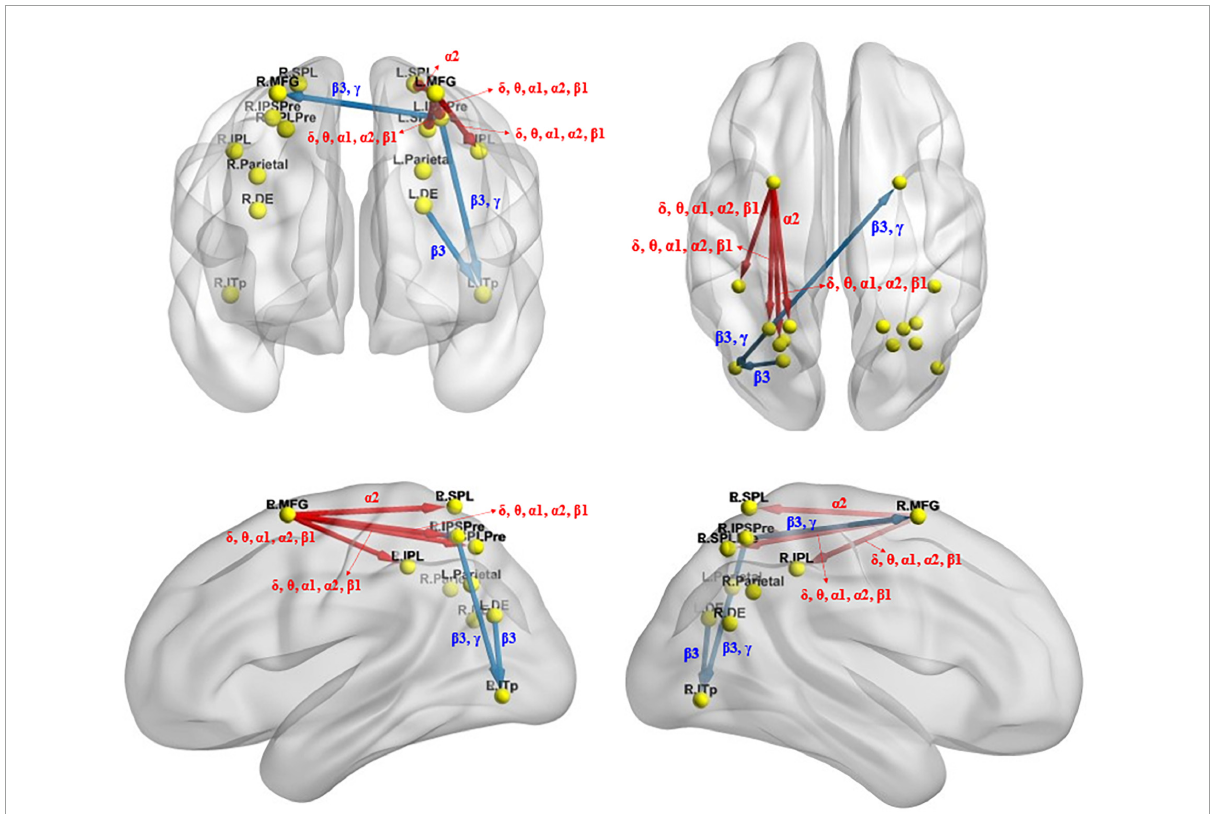
FIGURE6 Changes in effective connectivity under the identical condition after total sleep deprivation. Compared with before sleep deprivation, the effective connectivity from the L.MFG to the L.IPSPre, L.IPL, L.SPLPre, and L.SPL were significantly enhanced. The effective connectivity from the L.DE to the L.ITp, from the L.IPSPre to the L.ITp and the R.MFG were significantly reduced. Blue indicates that the strength of the effective connectivity is smaller after total sleep deprivation than before; Red indicates that the strength of the effective connectivity is greater after total sleep deprivation than before. The arrow indicates the direction of the connectivity; From top to bottom and from left to right: coronal view (frontal side) , axial view (dorsal side) , sagittal view (left side) , sagittal view (right side) . The main statistically significant results are summarized. L.ITp, left posterior inferior temporal lobe; R.ITp, right posterior inferior temporal lobe; L.DE, left dorsal extrastriate visual areas; R.DE, right dorsal extrastriate visual areas; L.Parietal, left parietal ROI; R.Parietal, right parietal ROI; R.IPSPre, right precuneus [the intraparietal sulcus]; L.IPSPre, left precuneus [the intraparietal sulcus]; R.IPL, right inferior parietal lobule; L.IPL, left inferior parietal lobule; R.SPLPre, right precuneus [superior parietal lobule]; L.SPLPre, left precuneus [superior parietal lobule]; R.SPL, right superior parietal lobule; L.SPL, left superior parietal lobule; L.MFG, left middle frontal gyrus; R.MFG, right middle frontal gyrus. Frequency bands: δ , 1.5–6 Hz; θ , 6.5–8 Hz; α 1, 8.5–10 Hz; α 2, 10.5–12 Hz; β 1, 12.5–18 Hz; β 2, 18.5–21 Hz; β 3, 21.5–30